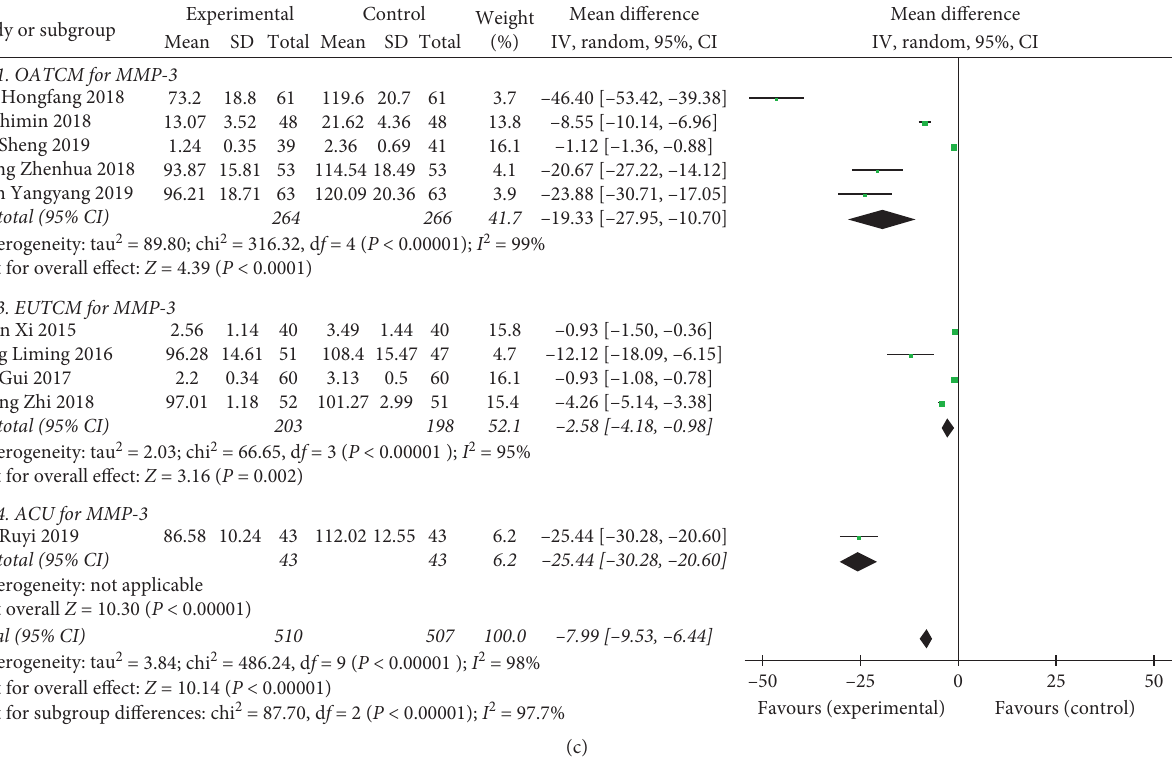
Figure 6: Forest plot of inflammatory cytokines in patients treated with TCM therapy and Western medicine therapy. (a) The plot of IL-1, (b) the plot of TNF- α , and (c) the plot of MMP-3. (I) 2 and (P) are the criteria for the heterogeneity test. ◆ : pooled mean difference, — ■ —: mean difference, and 95%CI. In the detection of inflammatory factors, due to differences in treatment methods, treatment cycles, detection environments, detection instruments, and detection personnel, the detection values vary greatly, but the directions are the same. Therefore, this indicator can be evaluated by the evaluation manager